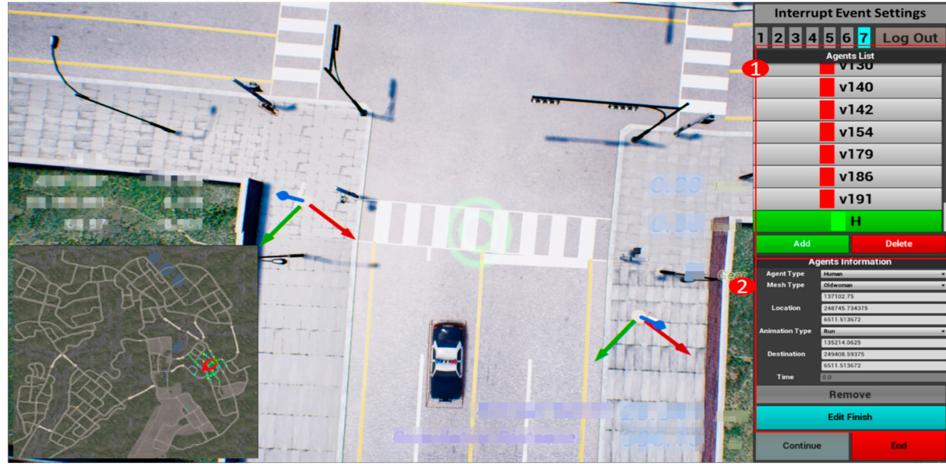
Figure 17. The editing UI of the interrupt event function.